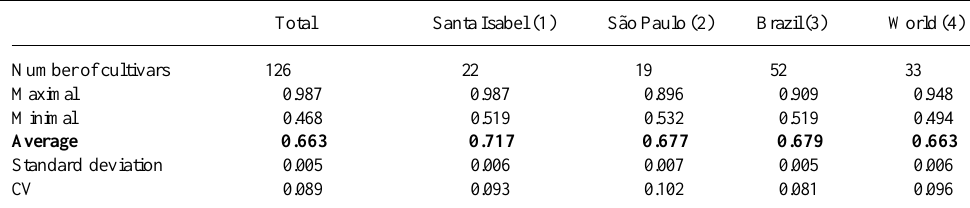
Table III - Simple matching coefficient values for cassava cultivar groups: Santa Isabel local cultivars, São Paulo State cultivars, accessions of the Brazilian group and accessions of the World collection.